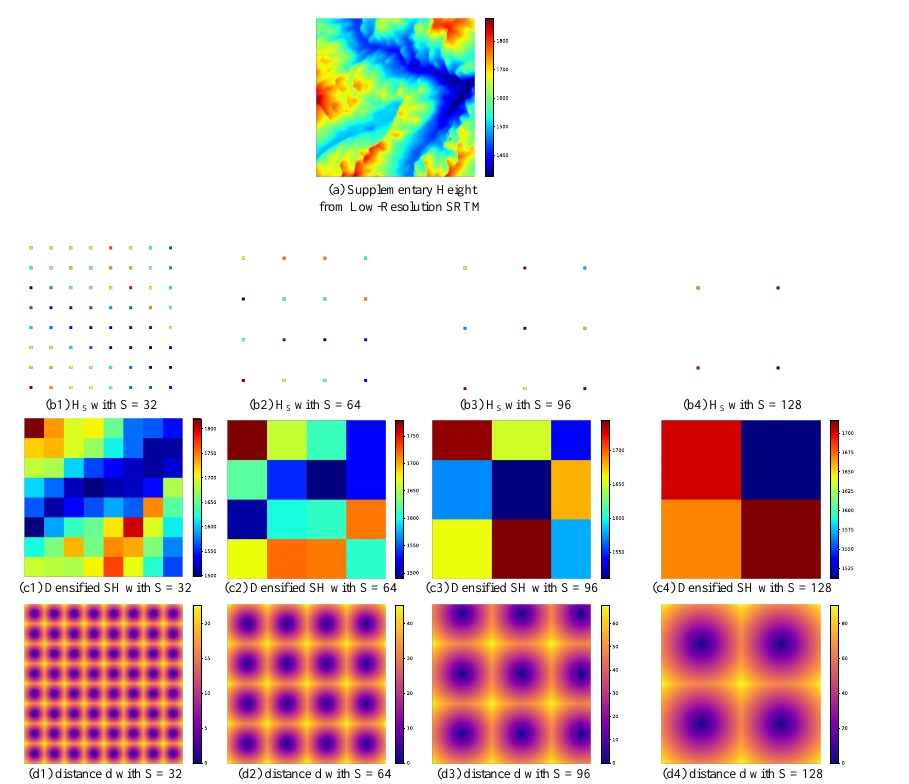
Figure 2. Generate original sparse height H S with different downsampling factors S × S from supplementary height map. Each image measures 256 × 256 pixels. To feed it to Unet, H S is densified by nearest neighbor filling (NNF). The densified sparse height is SH and the distance map from NNF is d . S is the downsampling factor. Details about the process is listed in Algorithm 1. Algorithm 1 Parameterized methods for generating inputs of